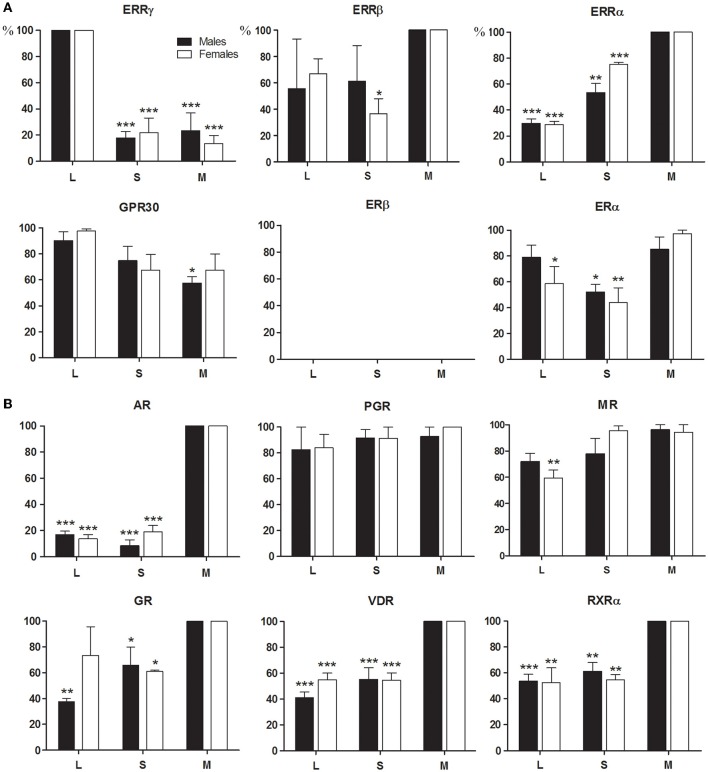
Expression profiles of steroid receptors during amelogenesis. RNAs extracted from microdissected rat enamel organ were analyzed by RT-qPCR after verifying the absence of mesenchymal and bone contamination. Dental cells from the secretion stage (S) and the maturation stage (M) were separately dissected using the molar reference line for isolation (See Materials and Methods). The cervical loop (L) that contains dental precursor cells, was anatomically distinguishable. The highest expression level ratio calculated for each studied and reference gene, using the standard curve method was set to 100% to compare data from the three independent experiments. Males (black bars) and females (white bars) were treated separately. The compared values were considered to be significantly different when *p <0.05, **p <0.01, ***p <0.001. (A) BPA receptors, ERRγ, and to a lesser extent GPR30 and ERα, were mainly expressed in the cervical loop, whereas ERRα and ERRβ were mostly expressed in the maturation stage. ERα and ERRβ expression pattern varied considerably between samples. ERβ was undetectable. (B) The other receptors able to mediate the effects of BPA were also expressed in the rat enamel organ, especially during the maturation stage. VDR and RXRα, two key receptors in amelogenesis, were also mostly expressed during the maturation stage.